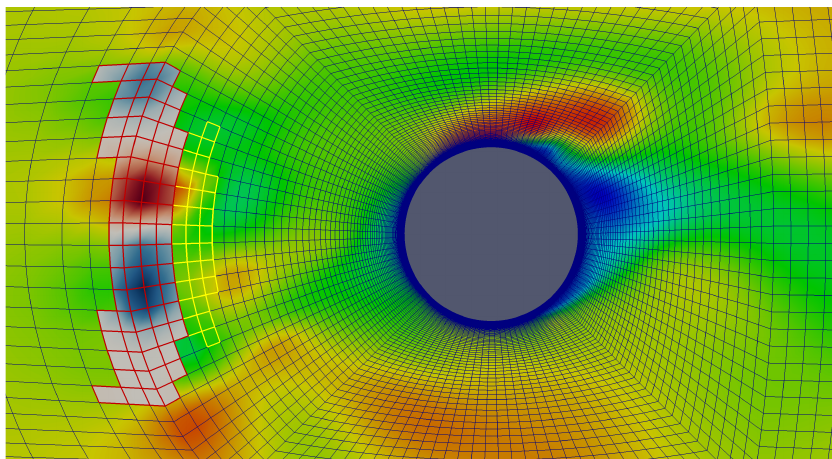
Figure 6. Stream-wise velocity u x field around the cylinder and volume force F syn x in the forcing region marked red. Controller measurement region marked yellow.